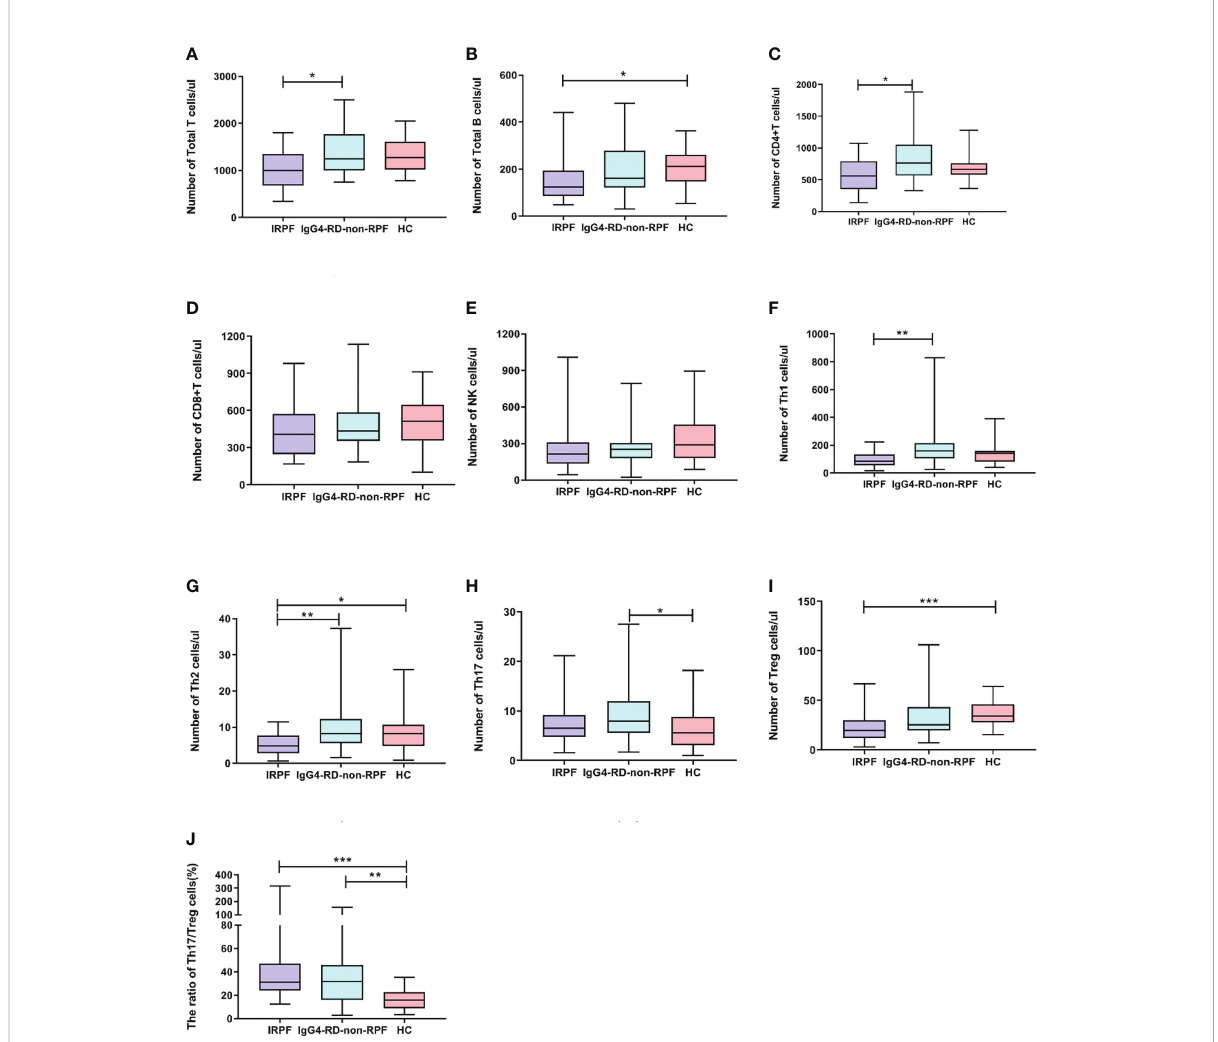
FIGURE 2 Comparison of lymphocyte absolute values and CD4+ T cell subsets IRPF group (n = 22), and IgG4-RD-non-RPF (n = 36) and healthy control group(n=28). Data were presented as mean ± SD. Shown signi fi cant differences are assessed by the Kruskal-Wallis H test. P < 0.05 was considered statistically signi fi cant. (*p < 0.05, **p < 0.01, and ***p < 0.001). (A – E) represent the differences in the absolute value of lymphocyte in three groups (corresponding to Total T, Total B, NK, CD4+T, CD8+T,respectively). (F – J) means the differences in absolute value of Th subsets of three groups (corresponding to Th1, Th2,Th17, Treg,